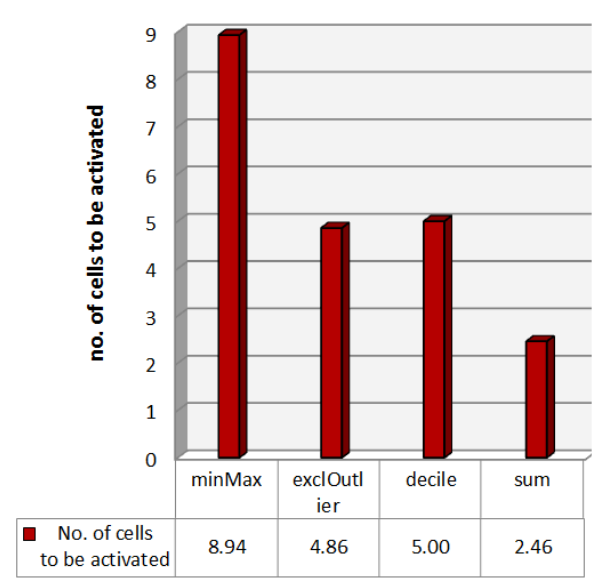
Figure 11. Average number of cells to be activated to include the candidate